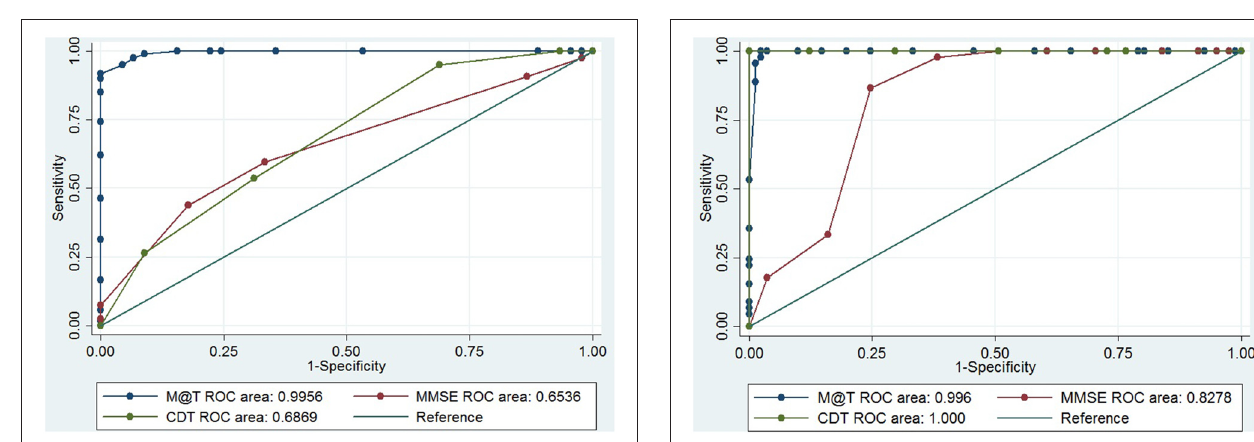
FIGURE 2 | Receiver operating characteristics (ROC) curve of M@T, MMSE and CDT to discriminate between patients with aMCI and controls in 166 low-level education individuals from Lima-Peru. MMSE, Mini Mental State of Examination; CDT, Clock Drawing Test—Mano’s version; M@T, Memory Alteration Test.